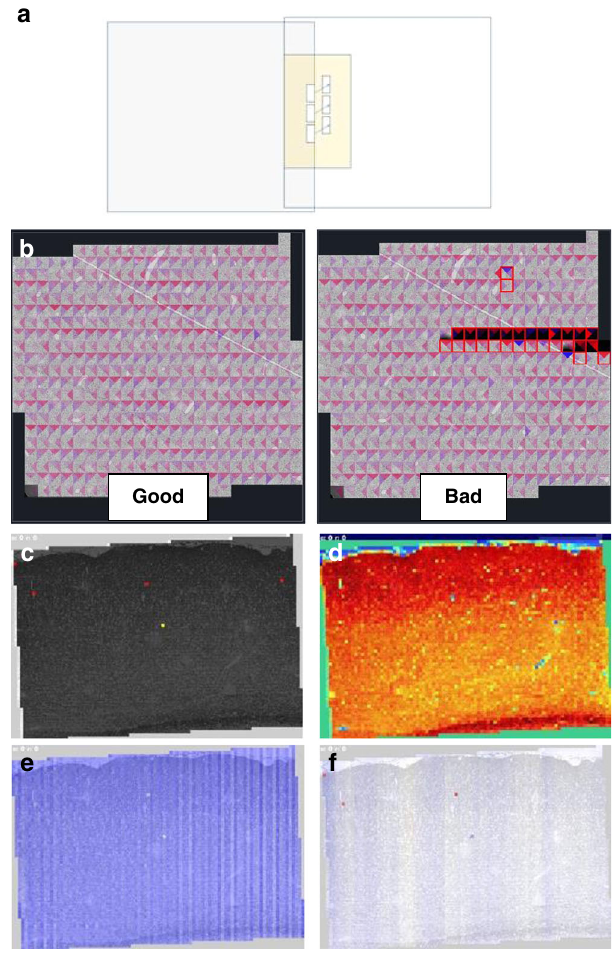
Fig. 3 Real-time quality control (QC) for capturing image and system errors. It utilizes the template matching to detect any tile overlap issue during acquisition, and FFT score to measure the focus quality of each tile. a Diagram representing the overlap region and template matching between two image tiles (blue boxes). The template search area (yellow box) is a region of twice the tile overlap (~13% for 20Mpix camera and 9% for 50Mpix). Three templates are used per edge, and the mean and standard deviation of the three matching vectors are returned from the fi lter. b Good vs. Bad real-time matcher results displayed on GUI: each triangle represents a matching result (top and down or left and right). Blue hues indicate that the template is found beyond the expected position, and red hues indicate that the template is found before the expected position, and the intensity represents the magnitude of the offset between the ideal and actual locations. To test the matching operation, we introduced two types of errors shown in the bad montage. The stage position was arti fi cially perturbed on row 4, and then on rows 10 – 11 the beam was blocked, resulting in black tiles. If the number of matched templates or the standard deviation of the template match vectors fail to meet thresholds, the tile is marked as an error. Imaging problems are usually detected as fl agged tiles in the quality map or non-uniform QC output maps. See example QC output maps: c matcher quality map; d focus map (color code is arbitrary as color is used only to identify any non-uniform pattern); e x-offset from ideal; f y- offset from ideal. Blue hue indicates positive stage offset comparing to the target position, and red hue indicates negative offset. The intensity represents the magnitude of the